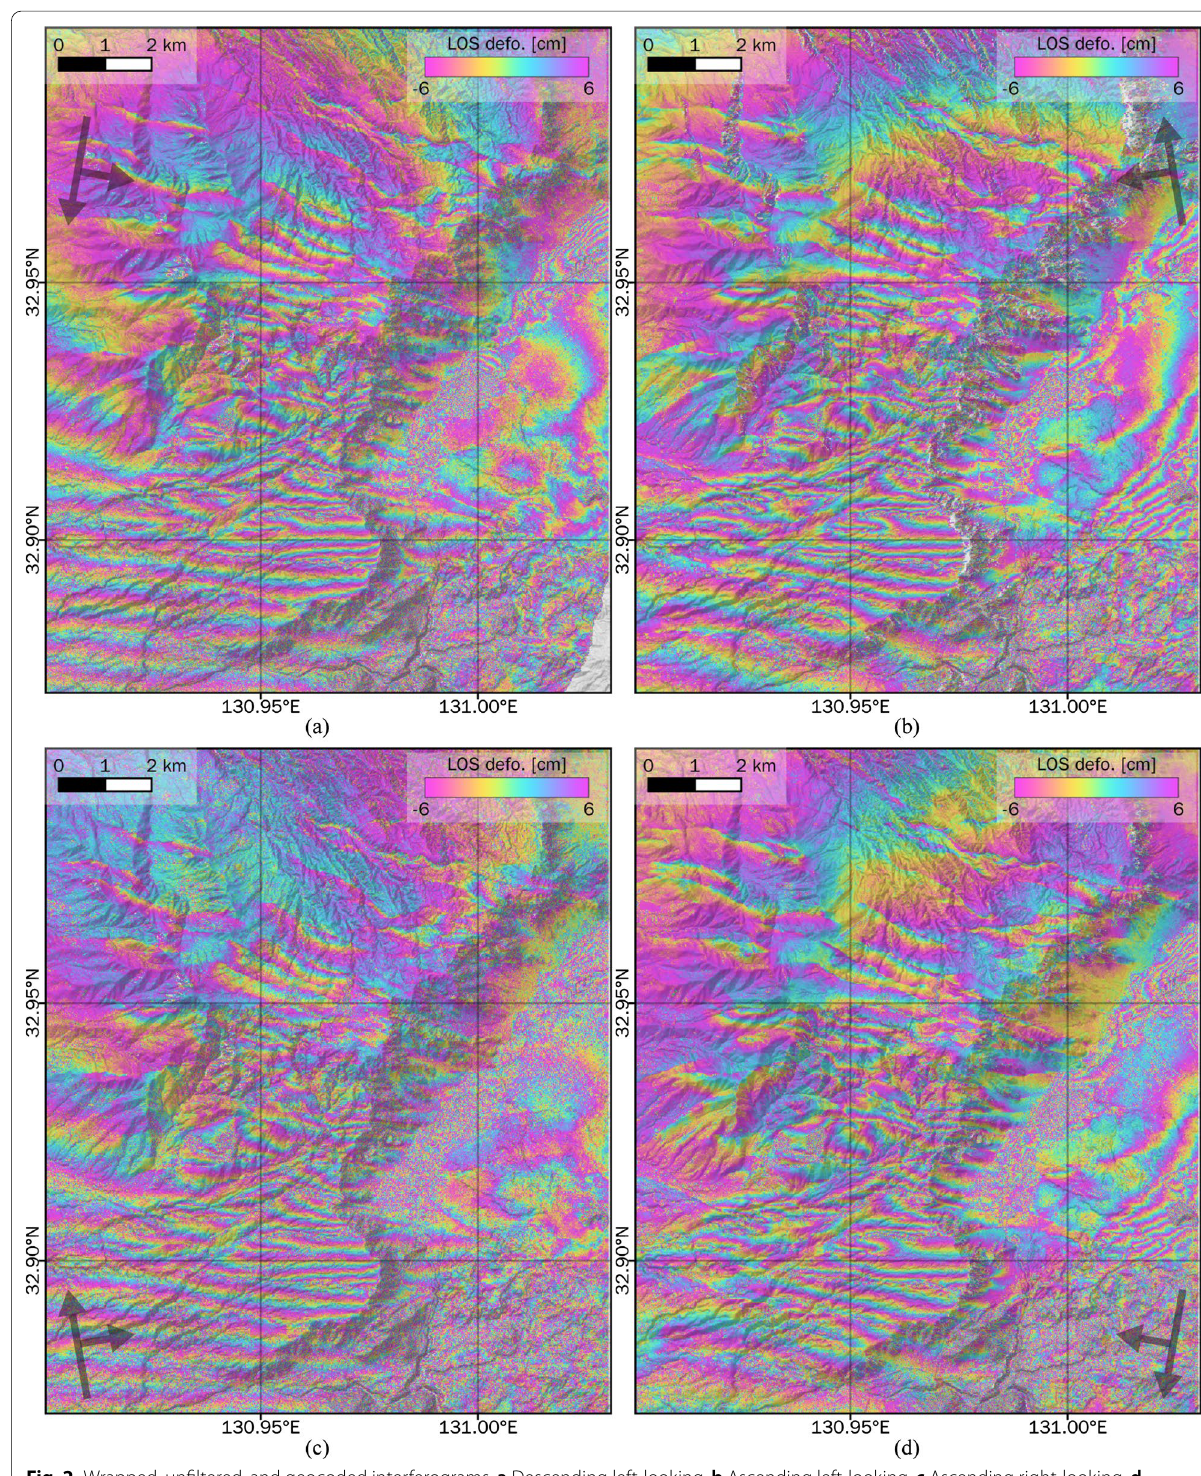
Fig. 2 Wrapped, unfiltered, and geocoded interferograms. a Descending left-looking. b Ascending left-looking. c Ascending right-looking. d Descending right-looking. For more detailed information on each interferogram, see Table